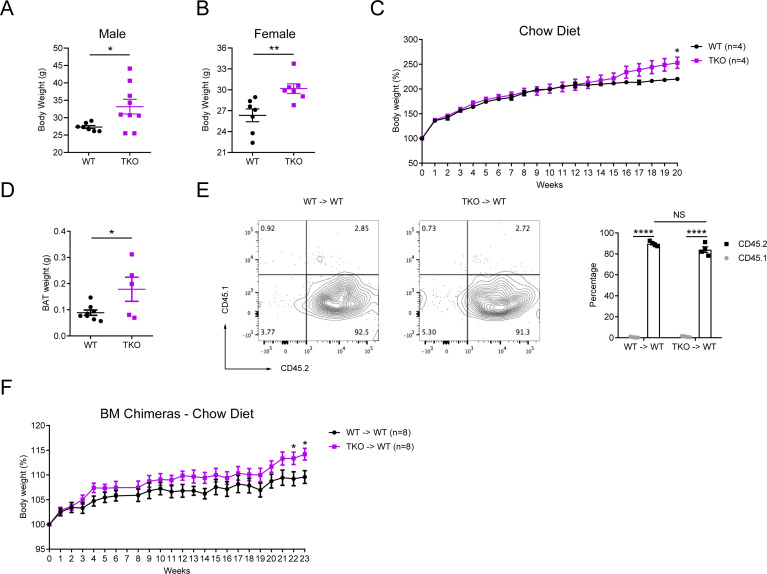
miR-17~92 family miRNAs play an important role in protection of mice from obesity.(A–B) Body weights of the Lyz2-Cre (WT) and TKO male (A) or female (B) mice at the age of 30 weeks (n = 7–9 per group). (C) Body weights of WT and TKO mice fed with regular chow diet, n = 4 per group. (D) Brown adipose tissue (BAT) weights of WT and TKO mice at the age of 30 weeks. (E) CD45.1 mice were irradiated and transferred with 106 donor bone marrow (BM) cells from WT (WT → WT) or TKO (TKO → WT) mice. Six weeks post BM transfer, CD45.1 and CD45.2 expression on adipose tissue macrophages (ATMs) was analyzed by flow cytometry. One representative experiment was shown in the left panel and cumulative data were shown in the right panel (n = 4 per group). (F) Body weights of chimeric mice transferred with WT (WT → WT) or TKO (TKO → WT) BMs fed with regular chow diet (n = 8 per group). Each symbol represents an individual mouse. *p<0.05, **p<0.01 and ****p<0.0001 (unpaired Student’s t-test). Data are representative or are pooled from two (A, B, D, and E) or one (C and F) independent experiments (mean ± sem).